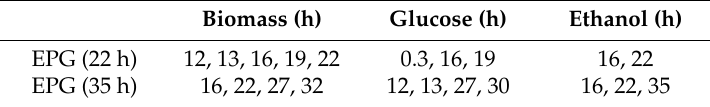
Table 2. Important measurement times for biomass, glucose and ethanol concentration that provide crucial information for the volumetric endopolygalacturonase (EPG) activity prediction model.